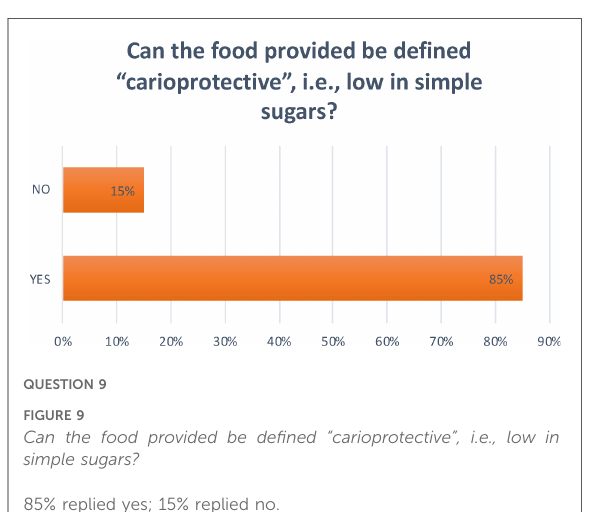
FIGURE 11 Do you have training and awareness-raising days devoted to this